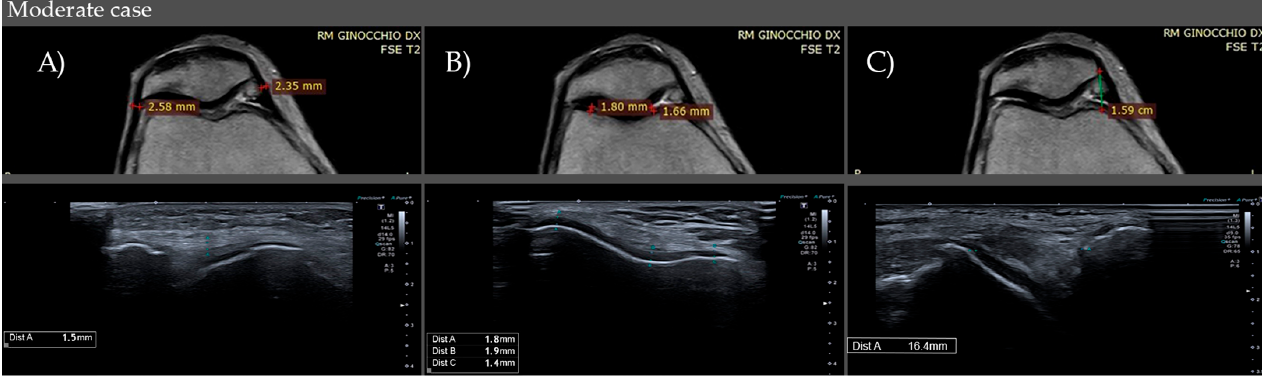
Figure 1. MRI and US values of retinacles ( A ) and cartilage ( B ) thickness and medial patello-femoral distance ( C ). Images of severe pathological cases.